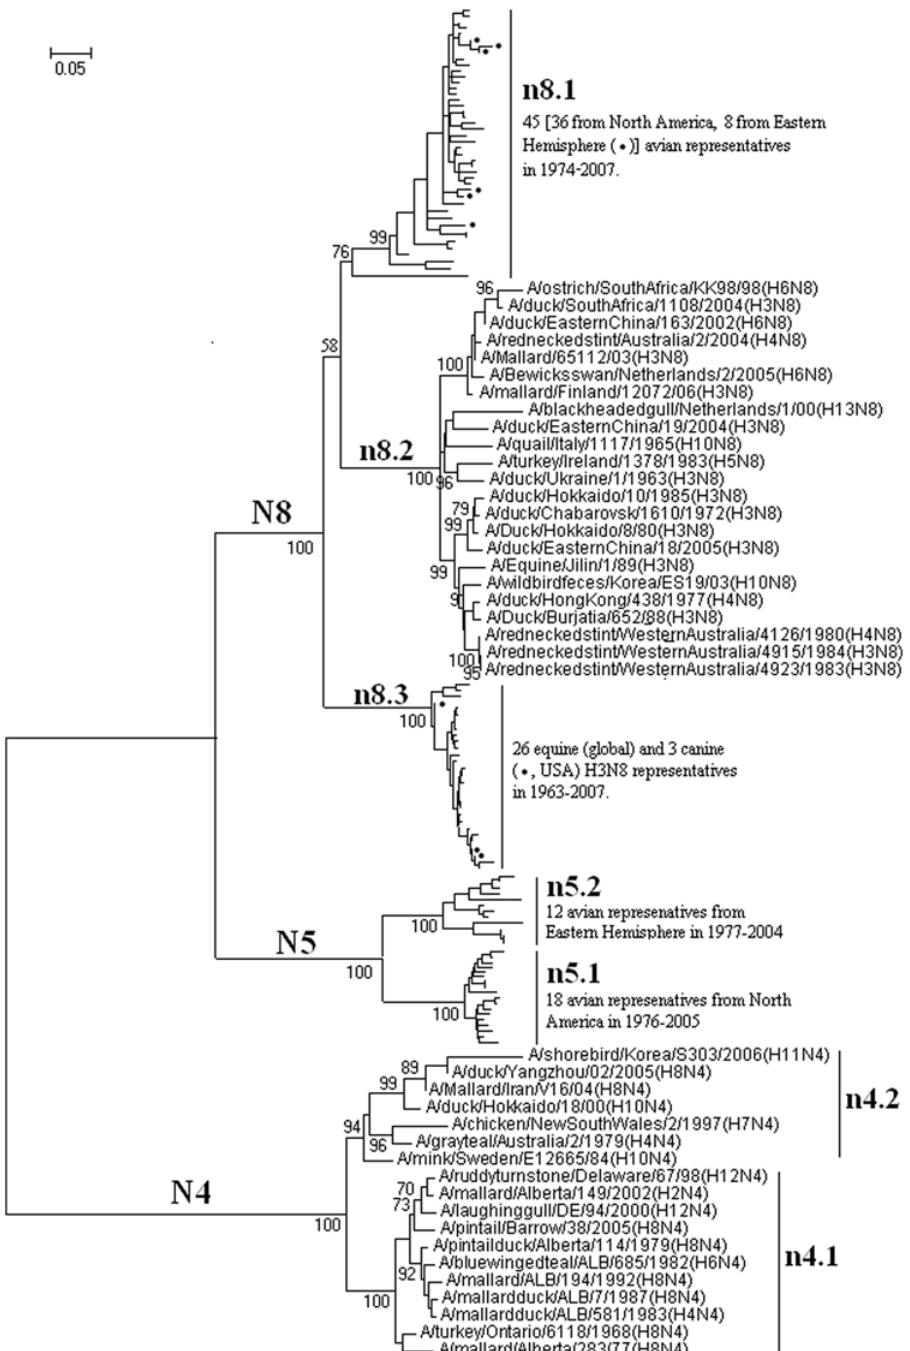
Figure 13. The panorama diversity of subtypes N4, N5 and N8 influenza viruses. Avian influenza viruses of these subtypes all could be classified into 2 lineages corresponding to the Western and Eastern Hemisphere, respectively, with some exceptions in sublineage n8.1. The equine H3N8 influenza viruses formed a separate lineage (n8.3) within subtype N8. Bootstrap values were given at relevant nodes.